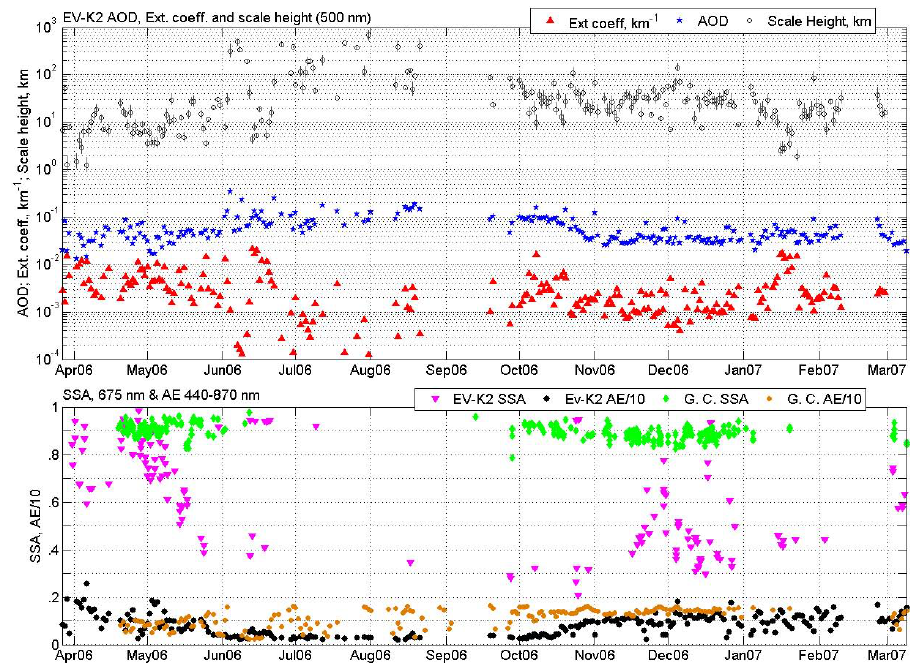
Fig. 6. (a) daily-average values of: 500nm AOD (blue stars); 500nm ground aerosols extinction coefficient (red triangles), and aerosol scale height H a (black circles) observed at the NCO-P. H a error bars represent its variability for refractive index ranging from m = 1 . 40 − 0.0001 (lower end) to m = 1 . 60 − 0.01i (upper end); (b) daily-average values of: the 440–870nm Angstrom exponent (AE, divided by 10) at Ev-K2- CNR (black dots) and at Ghandi College (orange circles), and 440nm aerosol single scattering albedo at Ev-K2-CNR (magenta stars), and at Ghandi College (green diamonds).